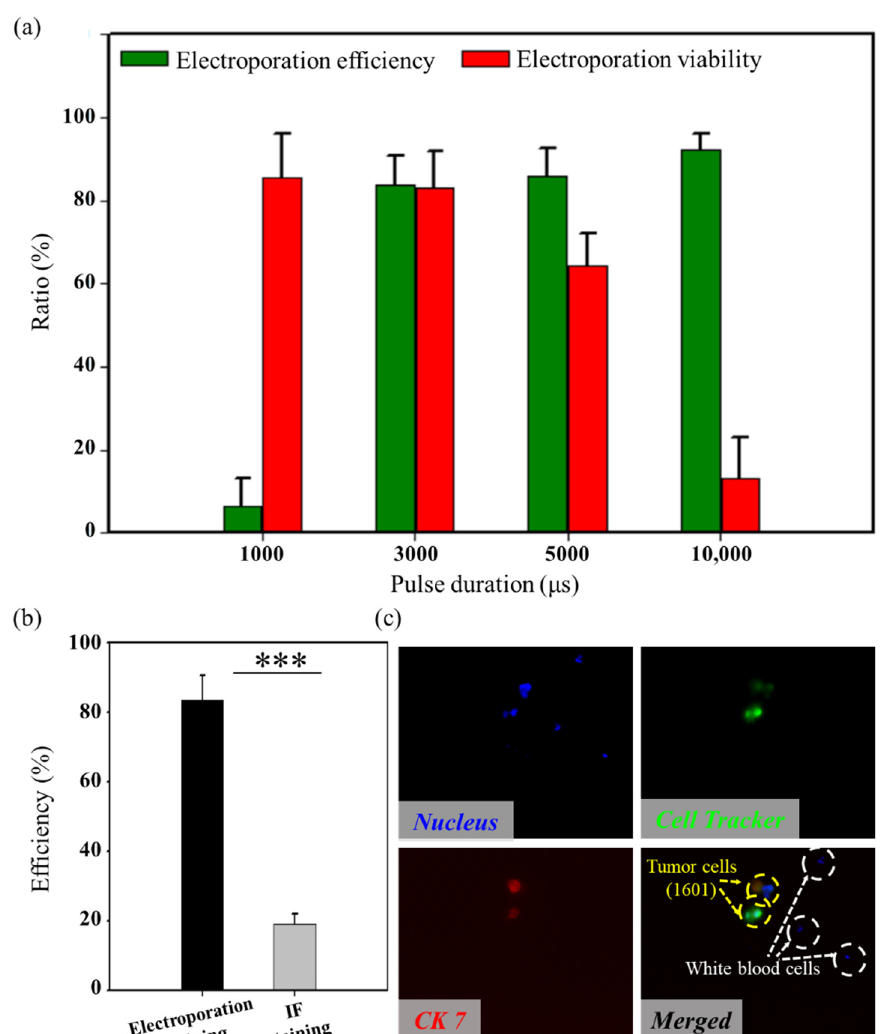
Figure 5. Transfection of dye-conjugated antibodies in 1601 cells. ( a ) The proteins electroporation efficiency and viability of 1601 cells under different pulse durations ( n = 3 for every trial). ( b ) A comparison of transfection efficiency for the proposed system and the traditional IF staining (Wilcoxon rank-sum test, *** p < 0.001) ( n = 3 for every trial). ( c ) Typical fluorescent images of tumor cell-specific electroporation.